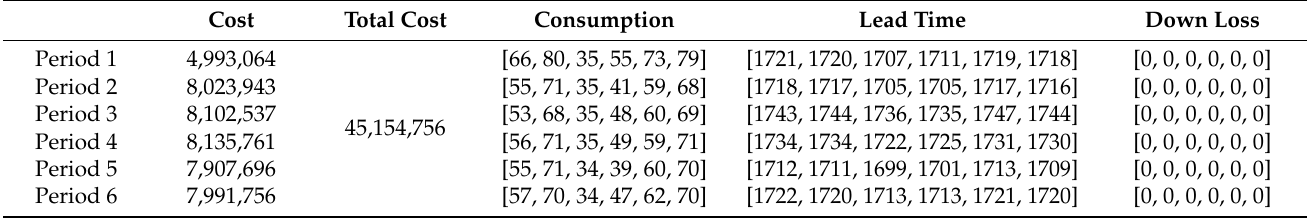
Table 2. Obtained results for optimal